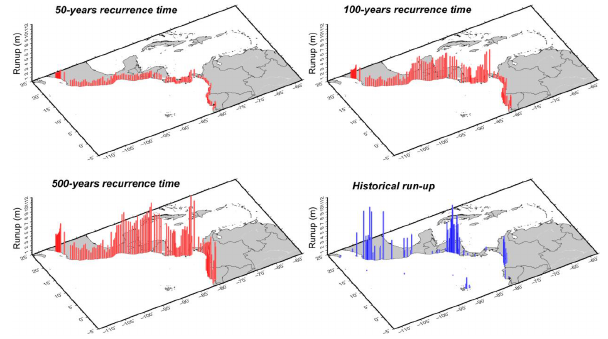
Figure 9. Maximum expected run-up height distribution for different return periods and observed historical run-up heights.